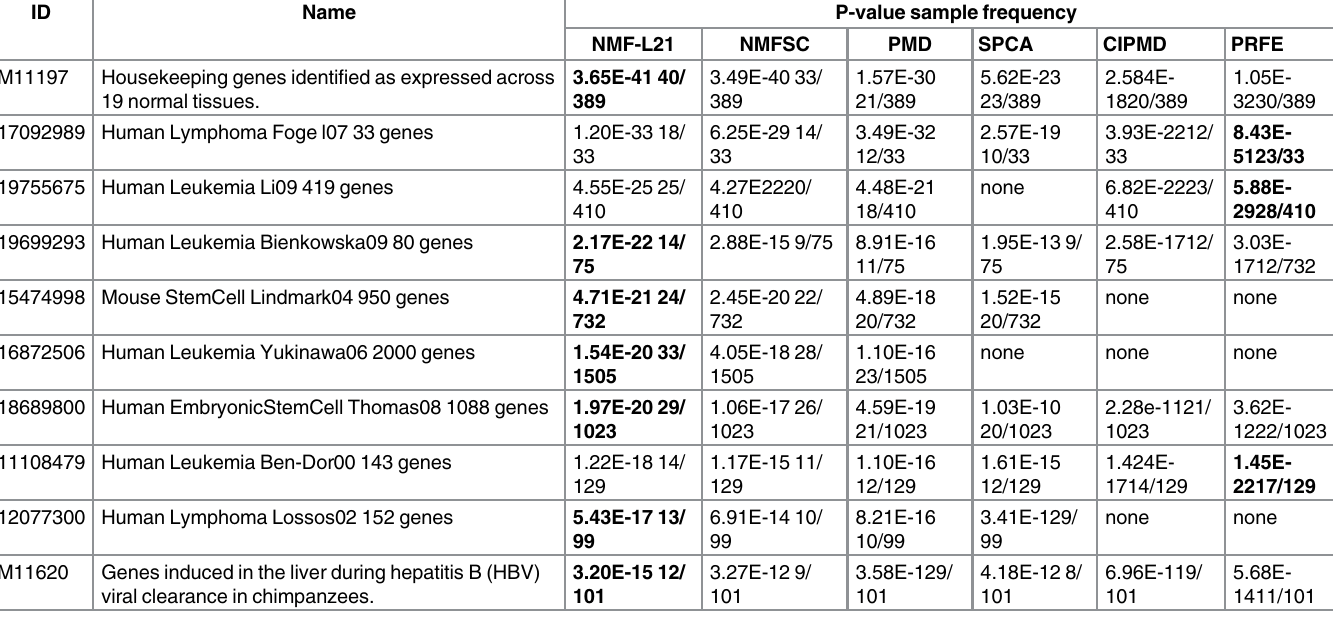
high-dimensional and nonnegative nature of the data. In summary, our method can cope with high dimensionality, non-negativity, sparseness and noise simultaneously. Furthermore, the genes selected by our method and others from both plant and tumor data- sets were compared using GO enrichment. These results indicate that the proposed NMF- L method is superior to SPCA and PMD for selecting characteristic genes. Table 7. P-value Terms for the Leukemia